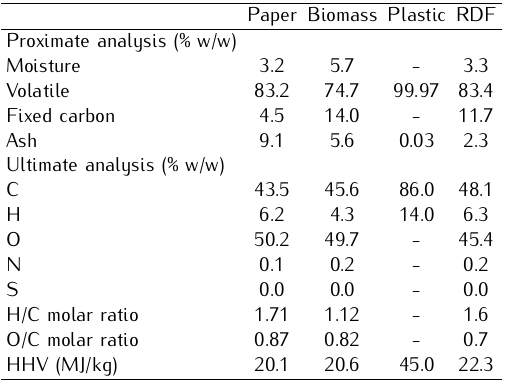
Table 1. Fuel Properties of Raw Materials Used Paper Biomass Plastic